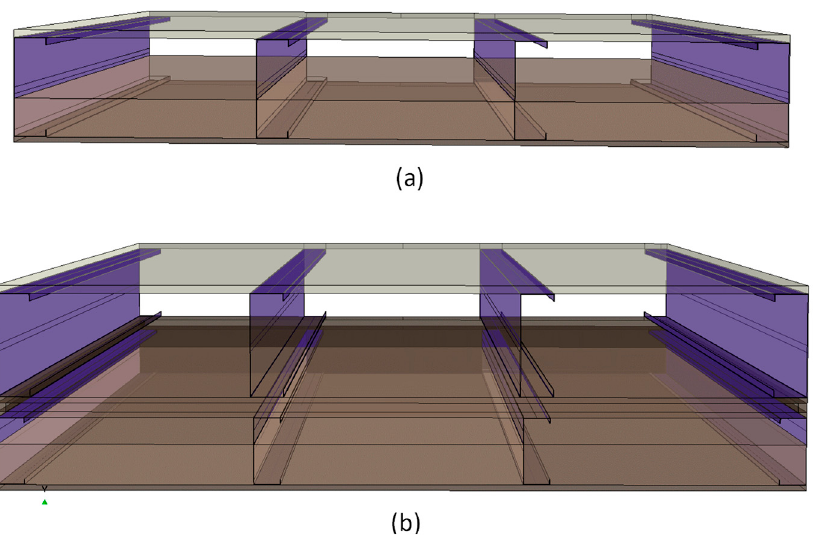
Figure 1. Construction of floor Systems: ( a ): conventional LSF floor and ( b ) modular LSF floor.